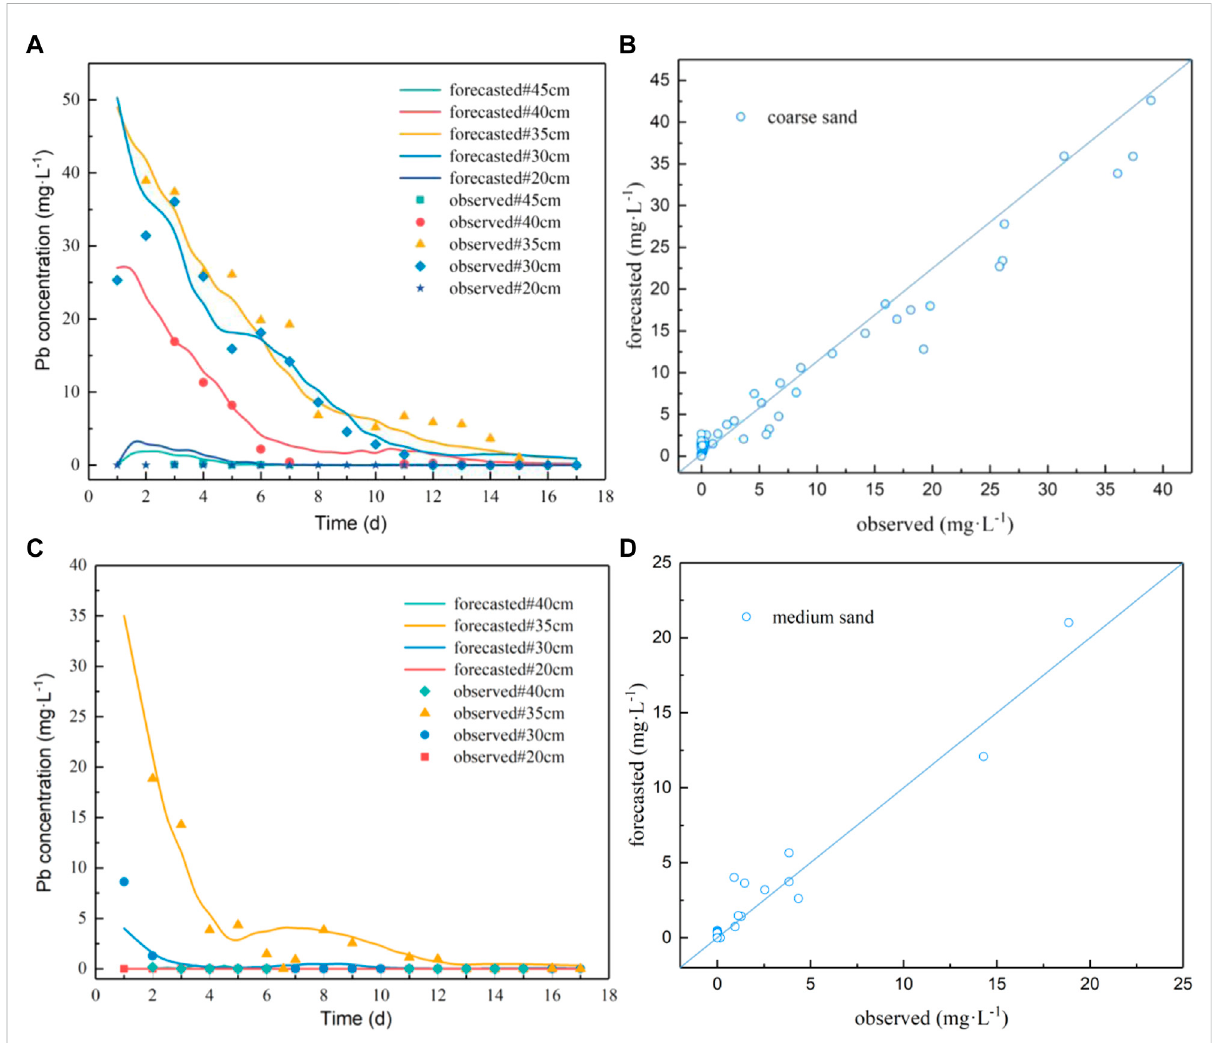
FIGURE 4 Comparison of observed results and forecasted results of Pb concentration in sampling water. (A) : Fitting curve of Pb concentration in water from coarse sand sampling port; (B) : the scatter plot of observed and forecasted values of Pb concentration in water from coarse sand; (C) : fi tting curve of Pb concentration in water from medium sand sampling port; (D) : the scatter plot of observed and forecasted values of Pb concentration in water from medium